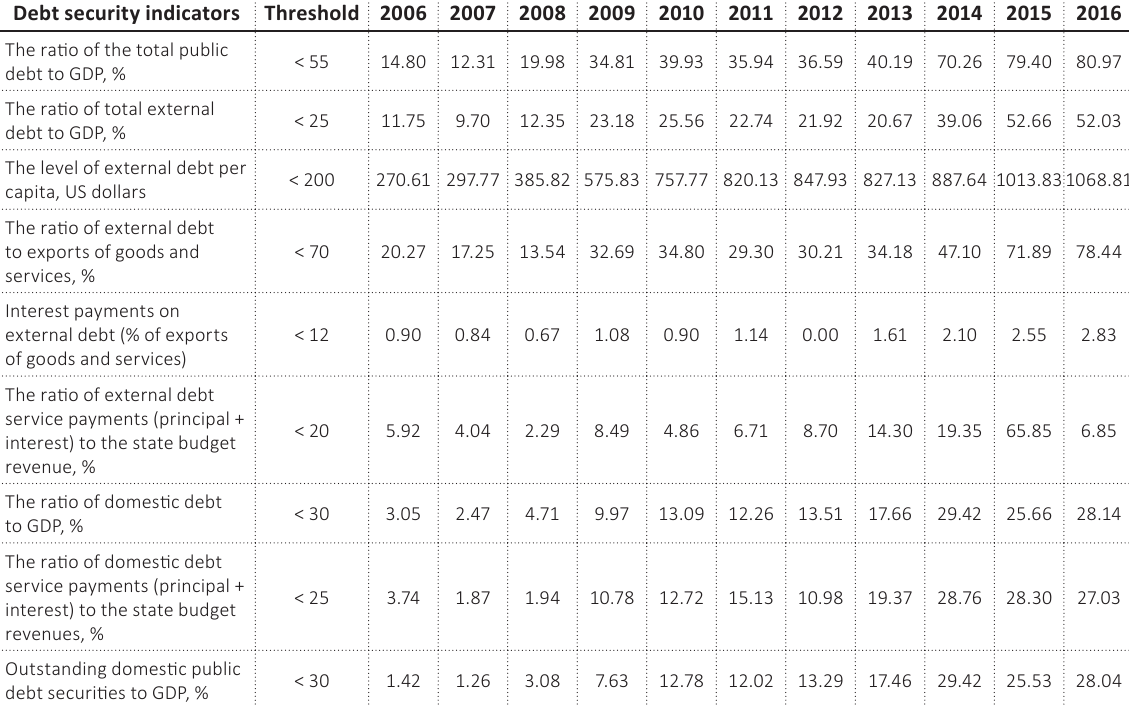
Table A1. Results of calculation of the debt security indicators (methodology from 2007)